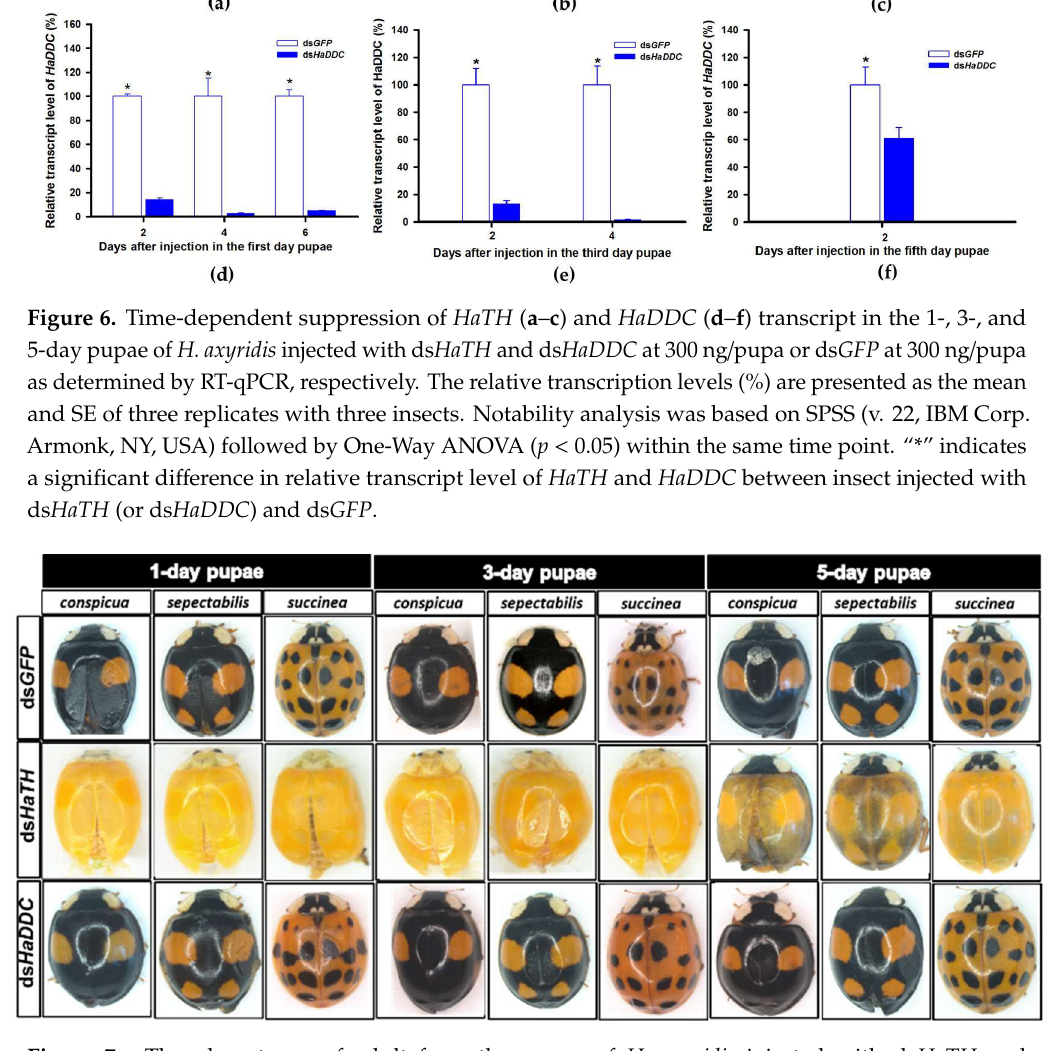
Figure 7. The phenotypes of adult from the pupae of H. axyridis injected with ds HaTH and ds HaDDC , respectively .